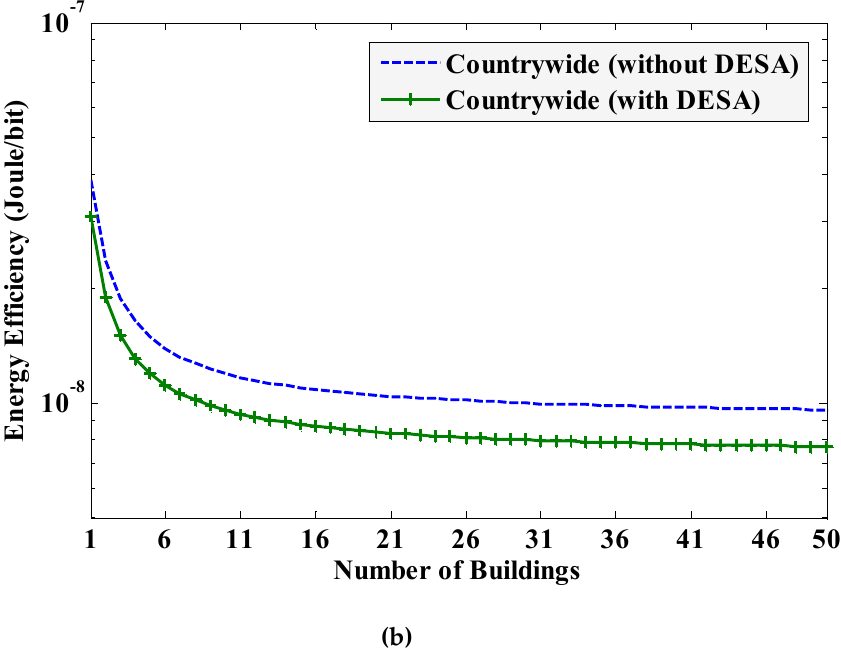
Figure 7. Countrywide SE and EE responses with the variation of the number of buildings of small cells L per MNO: ( a ) SE; and ( b ) EE.